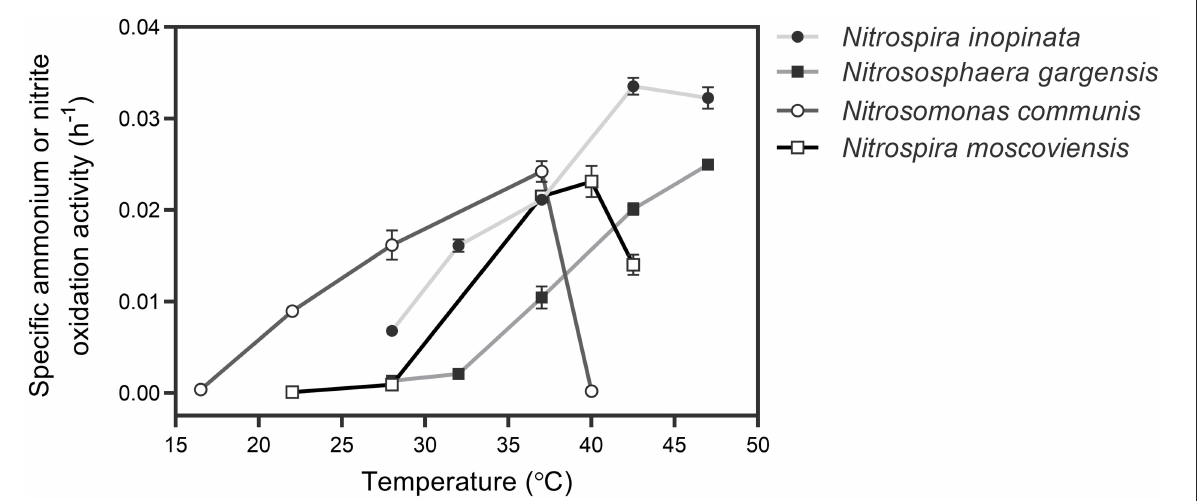
FIGURE1 Determination of the optimal temperature for culturing four types of nitrifiers. For comammox ( N. inopinata ) and AOA ( N. gargensis ), the temperatures were 28, 32, 37, 42.5, and 47 ◦ C, respectively; for AOB ( N. communis ), the temperature range was from 16.5 to 40 ◦ C; for NOB ( N. moscoviensis ), the temperature was controlled from 22 to 42.5 ◦ C. Data points show mean ± SE (standard error, n = 4). If not visible, error bars are smaller than